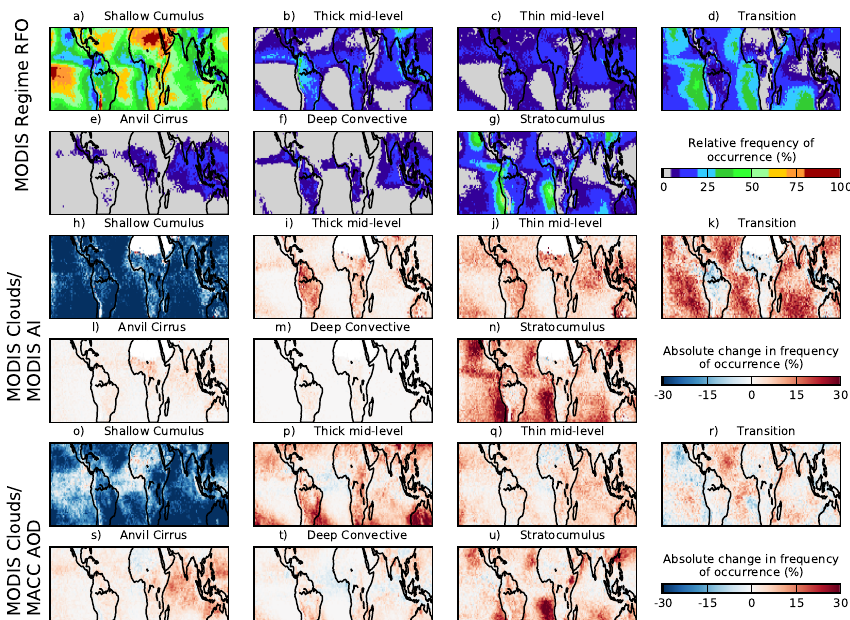
Fig. 2. (a–g) Relative frequency of occurrence (RFO) of each of the MODIS cloud regimes from Terra MODIS (2003–2011). The RFO is defined such that the sum of the RFOs for all of the regimes is 100%. (h–n) The difference in frequency of occurrence of the regimes between the lowest and the highest MODIS AI quartiles. (o–t) as (h–n) but using MACC AOD instead of MODIS AI as the aerosol product. Note that the effect of CF on the AI retrieval is not accounted for when determining changes in regime